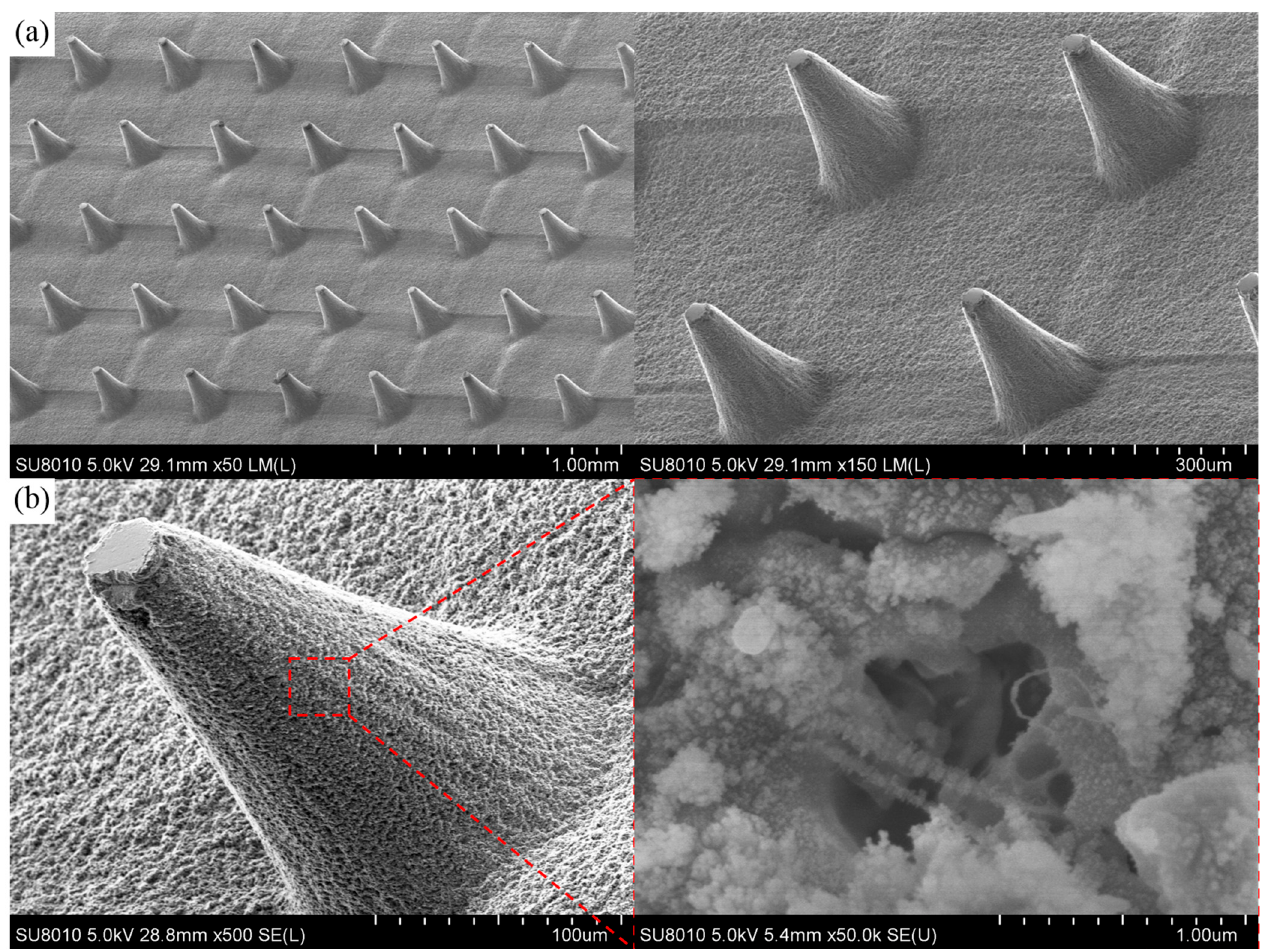
Figure 7. SEM image of ( a ) emitter array; ( b ) single emitter and surface feature.